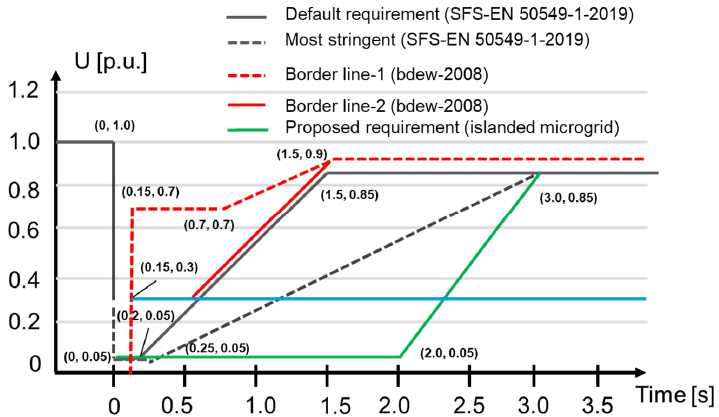
Figure 24. The low-voltage ride through (LVRT) capability of the nonsynchronous generators, including the converter-based generators: The red and blue voltage-time curves according to [32] and the black voltage-time curves according to [47]; the green voltage-time curve is the new proposed LVRT curve for the islanded mode of operation.